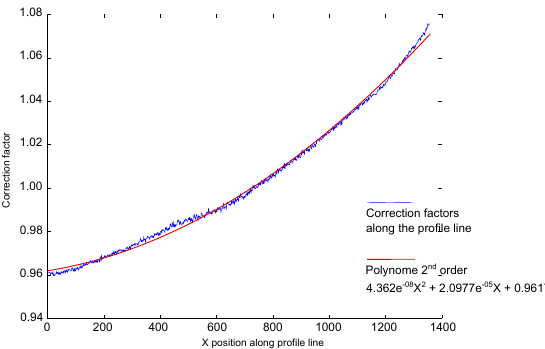
Figure 7: Profile through LED_NU, shown in figure 6.